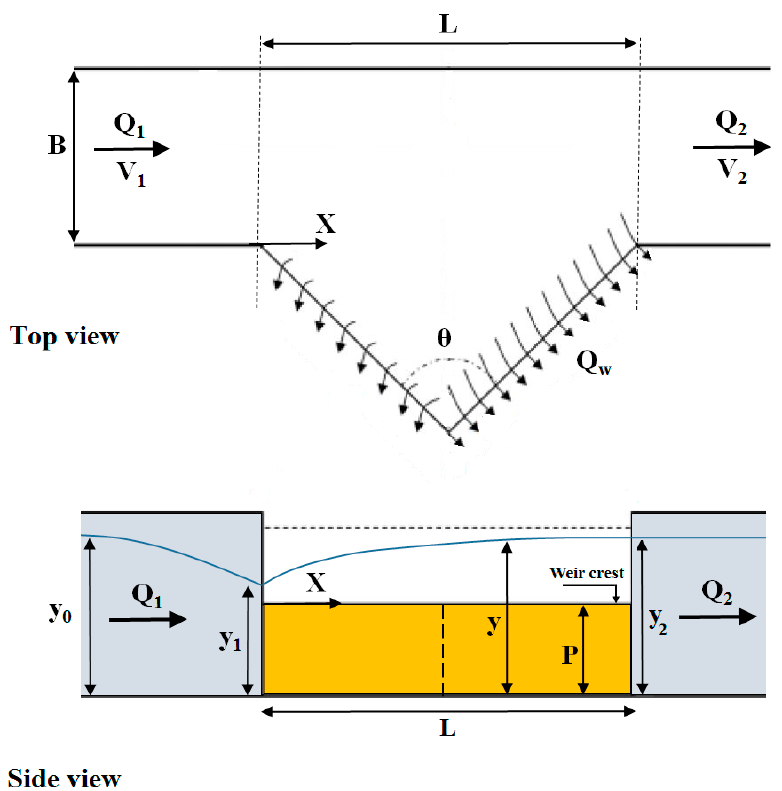
Figure 1. Schematic view of a triangular labyrinth side weir.